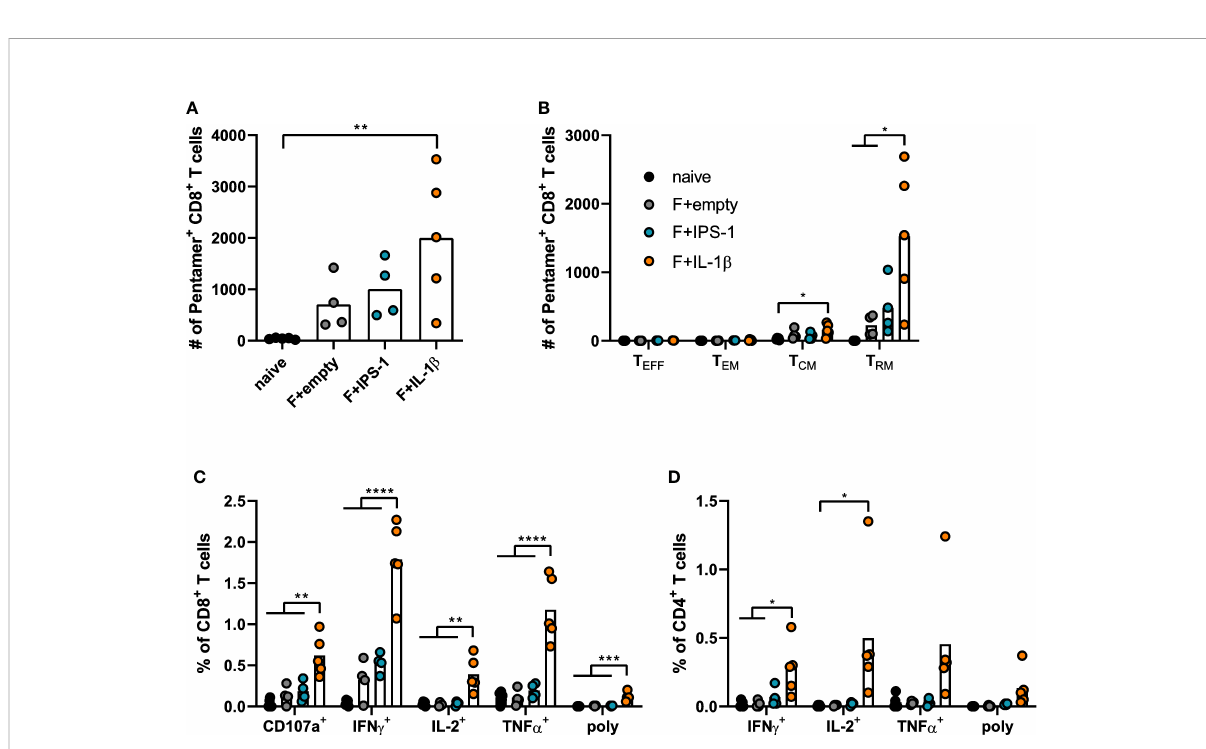
FIGURE 2 Vaccine-induced T cell responses in the lung. BALB/cJRj mice were immunized as described above and lung lymphocytes were analyzed 49 days later. Counts of F 85-93 pentamer + CD8 + T cells per lung (A) and counts of speci fi c memory T cell subsets (B) are shown; effector T cells, T EFF , KLRG1 + CD127 - ; effector memory T cells, T EM : KLRG1 + CD127 + ; central memory T cells, T CM : KLRG1 - CD69 - CD103 - CD127 + ; T RM : KLRG1 - CD127 +/- CD69 + CD103 + ; gating scheme in Supplementary Figure 2. (C, D) Lung lymphocytes were restimulated with MHC-class I and class II peptides derived from the F protein and the functionality of CD8 + T cells (C) and CD4 + T cells (D) was detected via extracellular staining for CD107a and intracellular cytokine staining (poly; for CD8 + : CD107a + IFN g + IL-2 + TNF a + ; for CD4 + : IFN g + IL-2 + TNF a + ; gating strategy in Supplementary Figure 3). Bars represent group means overlaid with individual data points. n=4-5. Data were analyzed by one-way ANOVA followed by Tukey´s post Test. * p <0.05, ** p <0.005, *** p <0.0005, **** p <0.0001.